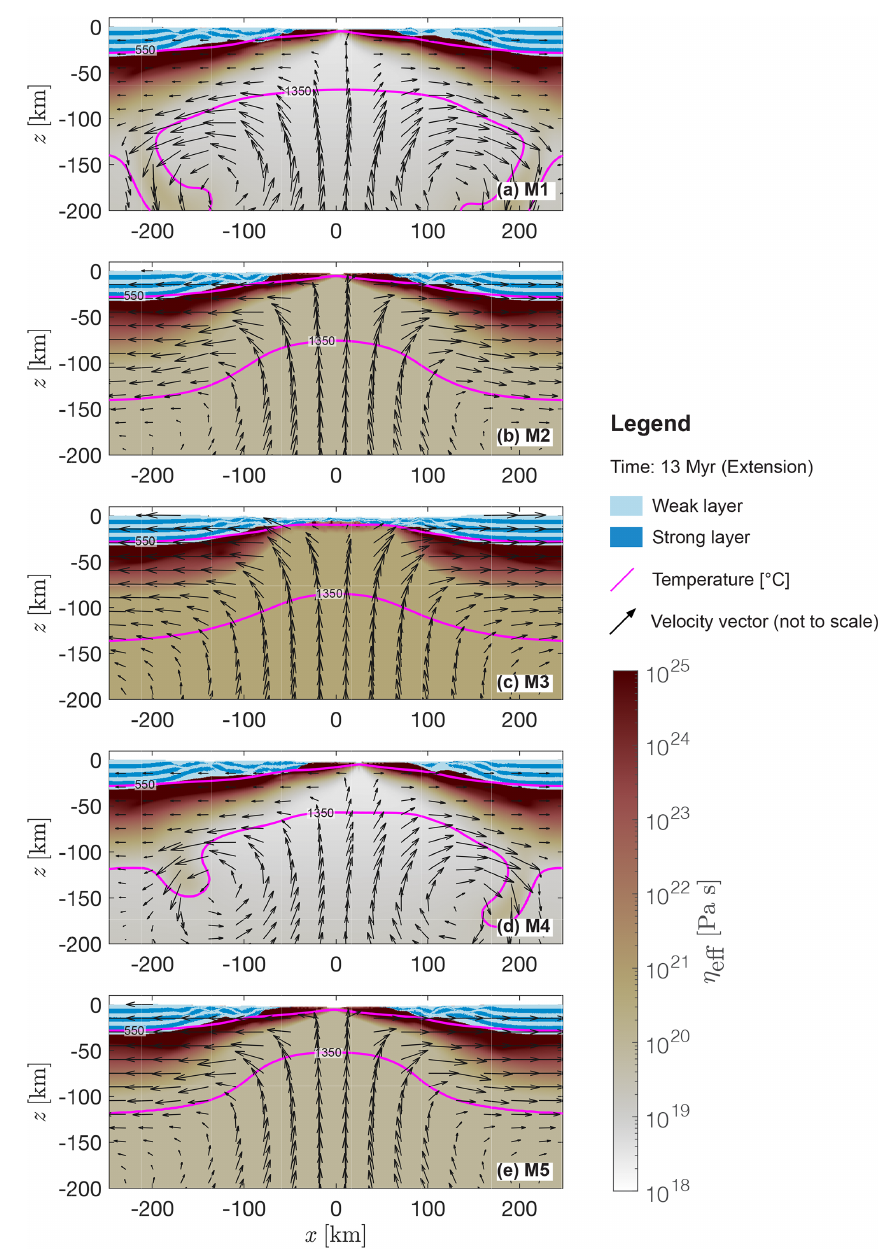
Figure 5. Comparison of M1–5 during the extension stage. (a–e) Enlargements of results of models M1–5 at 13Myr of modelled time. Blue indicates mechanically weak (light) and strong (dark) crustal units. White to red colours show the effective viscosity field calculated by the numerical algorithm. The magenta lines show the level of the550 and 1350 ◦ C isotherm. Arrows represent velocity vectors, and the length of the arrows is not to